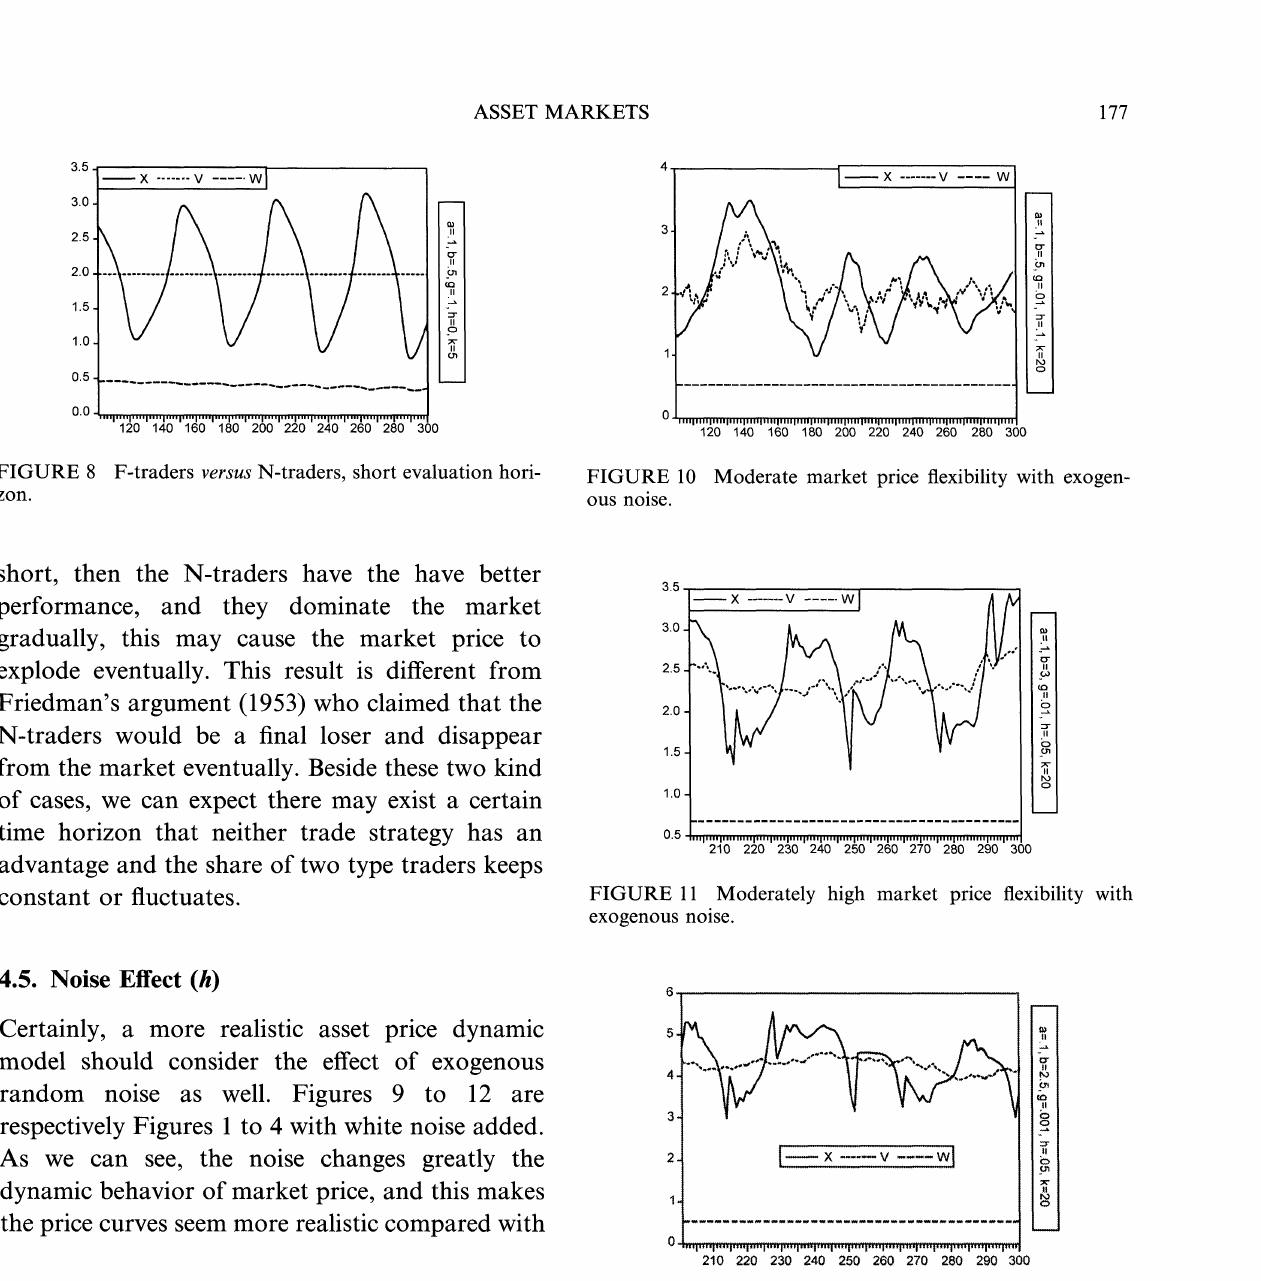
FIGURE 12 Very high market price flexibility with exogen- ous